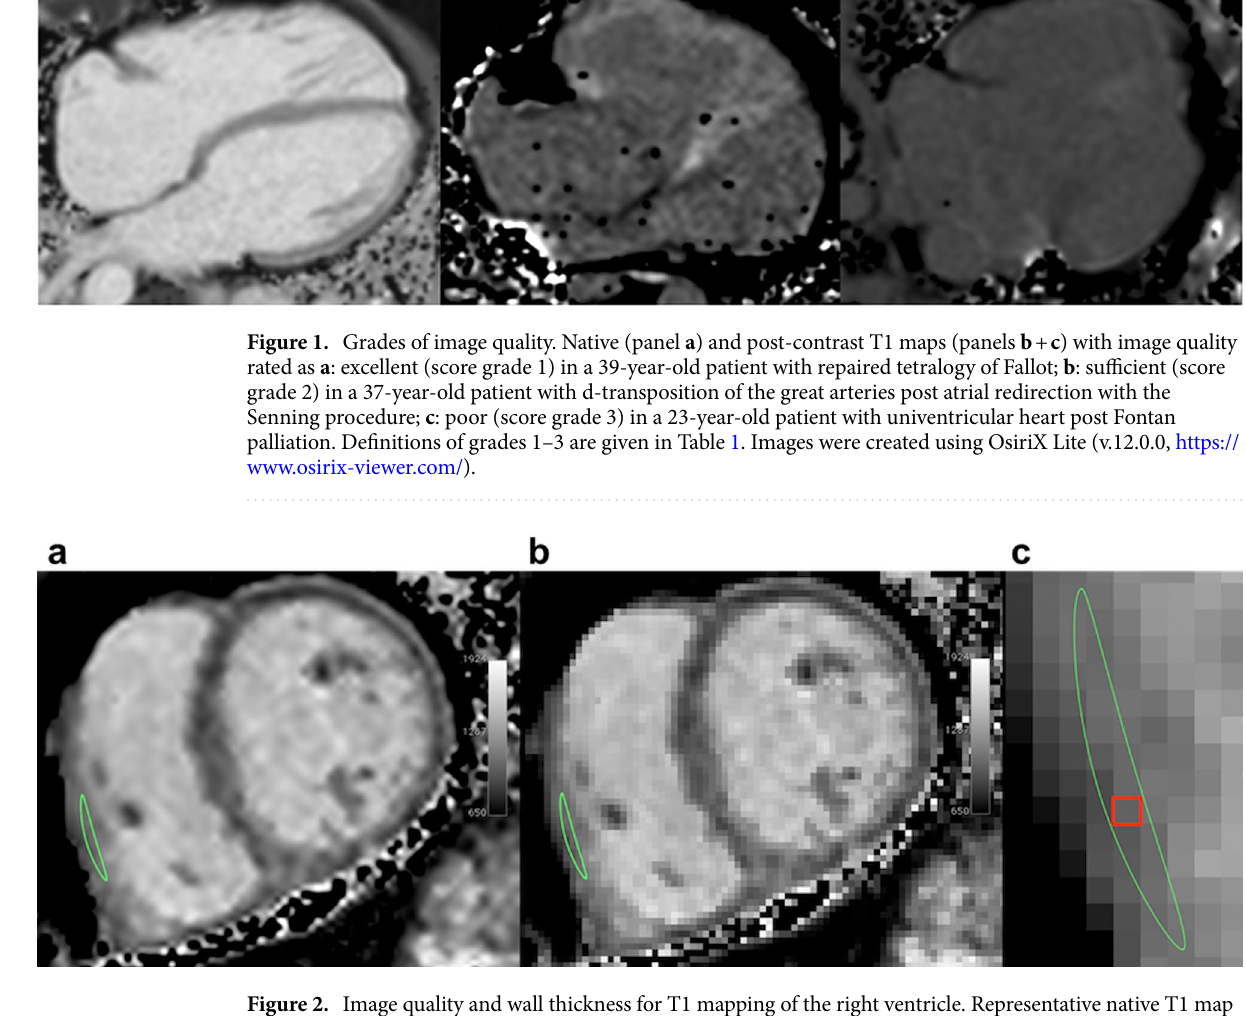
Figure 2. Image quality and wall thickness for T1 mapping of the right ventricle. Representative native T1 map of a 36-year-old patient with pulmonary stenosis demonstrating excellent image quality (score grade 1; panel a ) and right ventricular wall thickness of 1 pixel per region of interest (score grade 2; panels b + c ). Images were created using OsiriX Lite (v.8.5, https ://www.osiri x-viewe